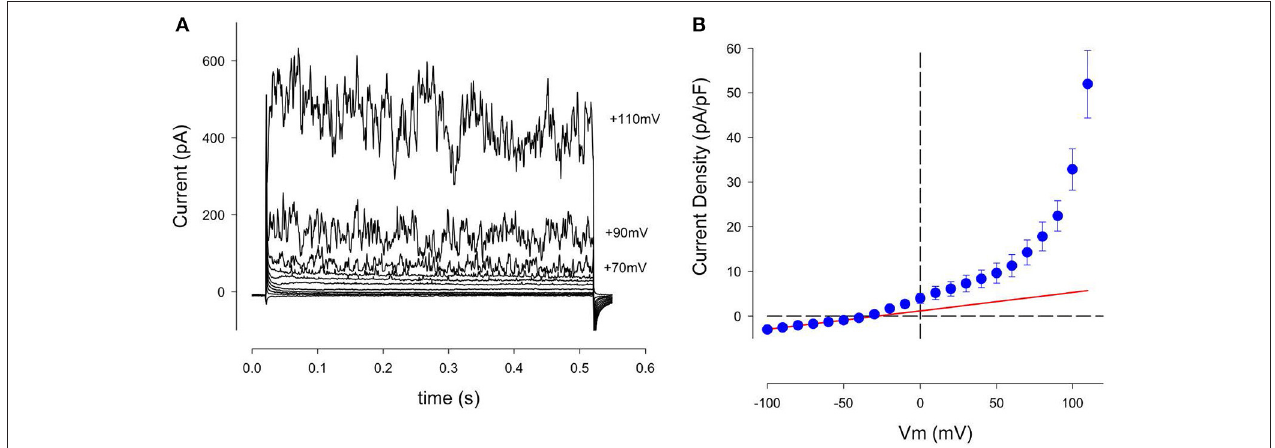
FIGURE 2 | Family of K + currents recorded from an isolated human chondrocyte maintained in primary 2D culture conditions. (A) These currents were recorded from a chondrocyte that was held at 80mV, and then stepped to membrane potentials between − between 90 and 100mV, (in 20mV increments). This chondrocyte had been in culture for 3 days; its capacitance, C m , was 7.3 pF. Panel (B) is an averaged − + current-voltage (I–V) relation for 13 cells, (1 day in culture). Currents recorded from each cell were normalized to cell capacitance before averaging. Solid red trace is the best-fit straight line between 100 and 50mV. Its slope is 0.042 nS/pF. Mean − −